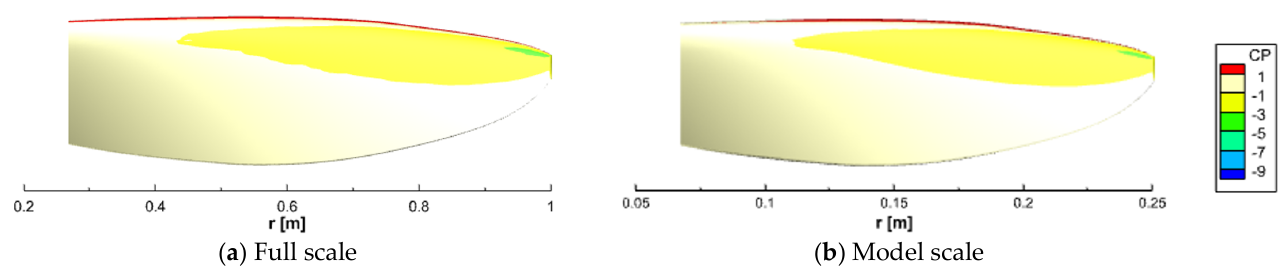
Figure 17. Comparison of the blade surface pressure distribution (suction side) at J = 1.52; pitch angle = 34°.